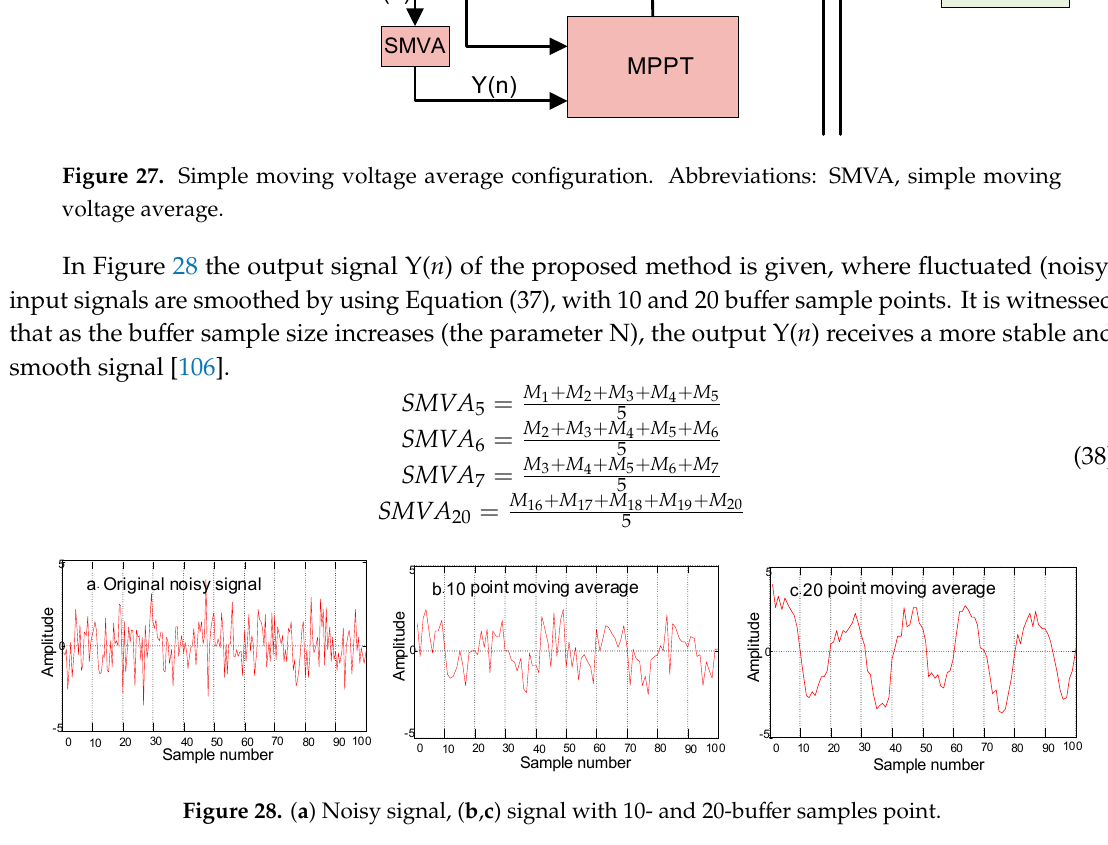
Figure 27. Simple moving voltage average configuration. Abbreviations: SMVA, simple moving voltage average.